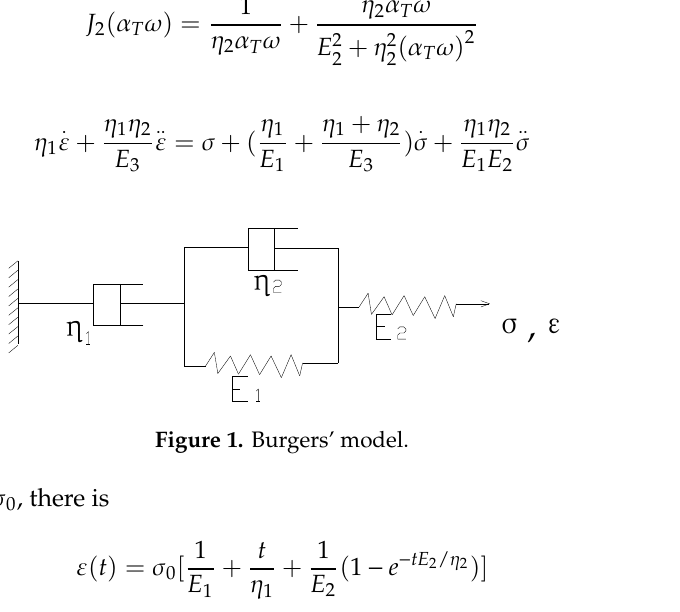
Figure 1. Burgers ’ model. Figure 1. Burgers’